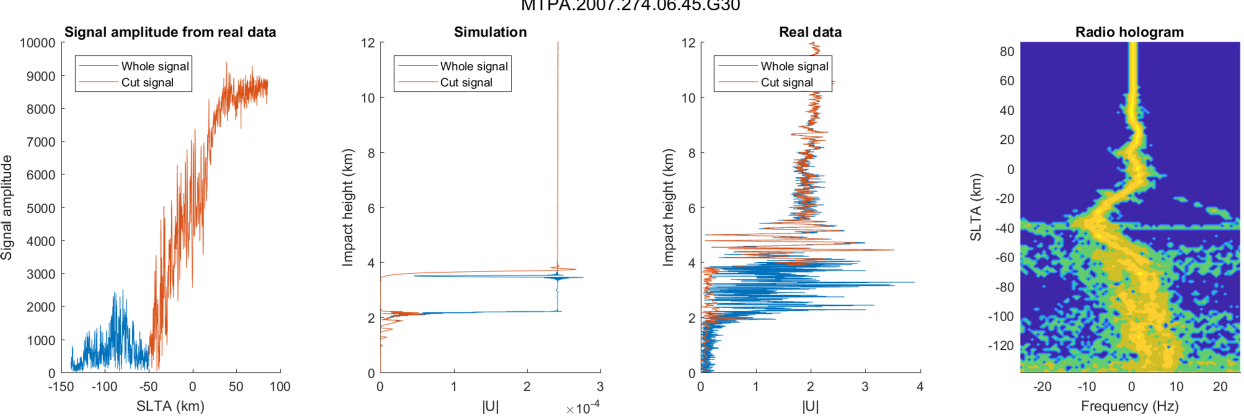
Figure 10. An event classified as category 3. SLTA min is at approximately − 85km, and the signal is truncated at SLTA = − 50km. The reflection spike is located at an impact height of 1928m, and a min is 2200m.